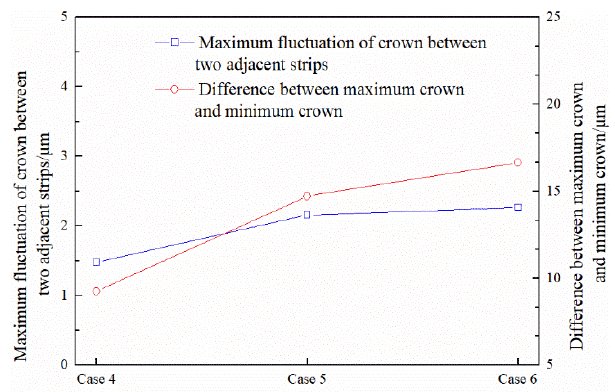
Figure 14. Strip crown fluctuation index in middle and later stage of rolling unit.